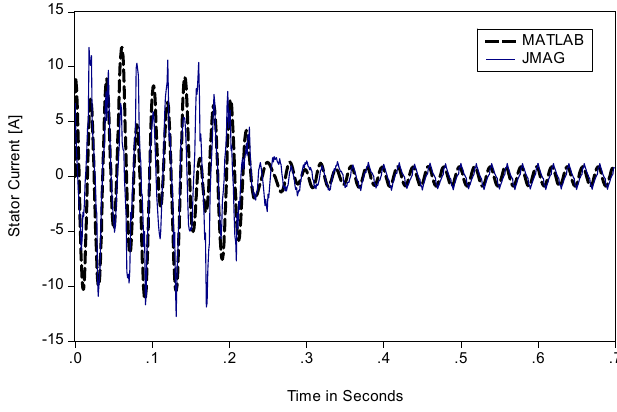
Figure 9. Speed at 1.5 N ∙ m load.